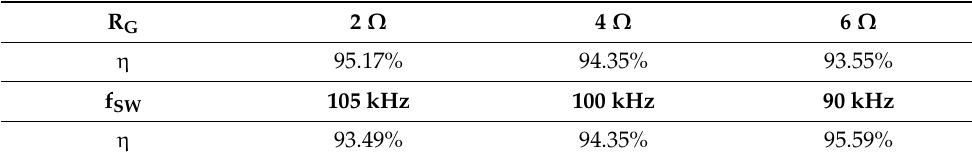
Table 3. Outcome of the parametric analysis conducted on the DC-DC converter: the efficiency ( η ) evaluated at different R G and f SW